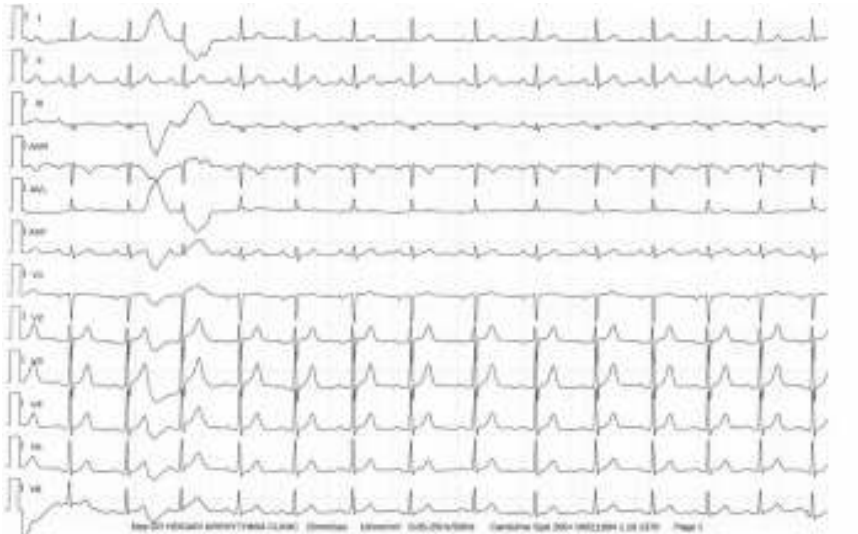
Figure 3 . Electrocardiograph after Ledibiox